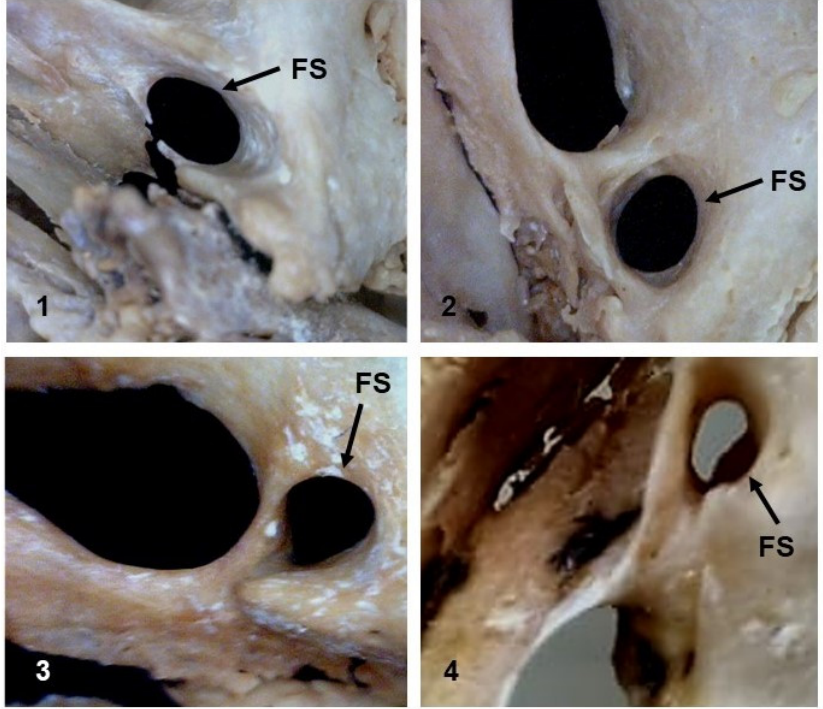
Figure 6. Inferior view of the skull showing the different shapes of the foramen spinosum. Oval ( 1 ), round ( 2 ), drop ( 3 ), and irregular ( 4 ).